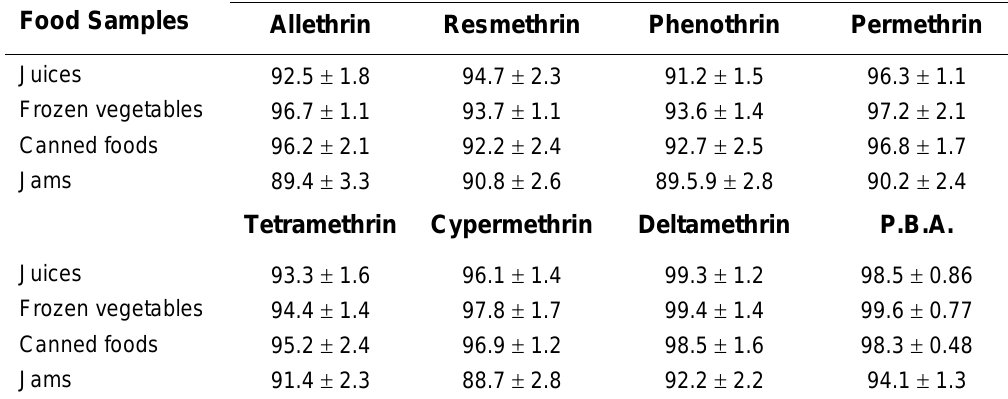
Pyrethroid Recovery and RSD Percentages of Spiked Food Samples Extracted by SFE and Determined by SFC/UVD at 220